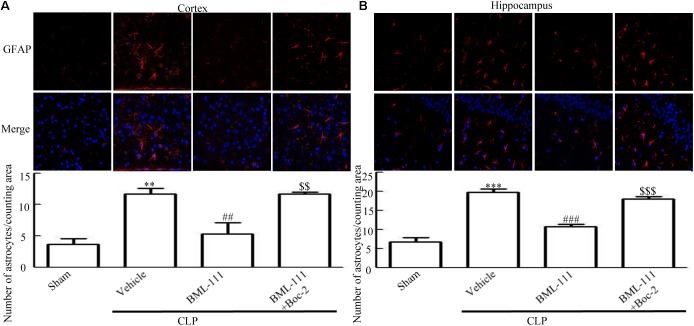
BML-111 treatment reduces the activation of astrocyte in mice with sepsis. (A,B) CLP up-regulated the GFAP-positive cells significantly compared with the sham group. BML-111 treatment decreased the number of positive cells compared with the CLP + vehicle group, and Boc-2 reduced the effects of BML-111. Scale bars indicate 50 μm (n = 3 surviving mice per group per experiment). Data were shown as the means ± SEM. ∗∗P < 0.01, ∗∗∗P < 0.001 represent CLP + Vehicle vs. Sham, ##P < 0.01, ###P < 0.001 represent CLP + BML-111 vs. CLP + Vehicle, $$P < 0.01, $$$P < 0.001 represent CLP + BML-111 + Boc-2 vs. CLP + BML-111.